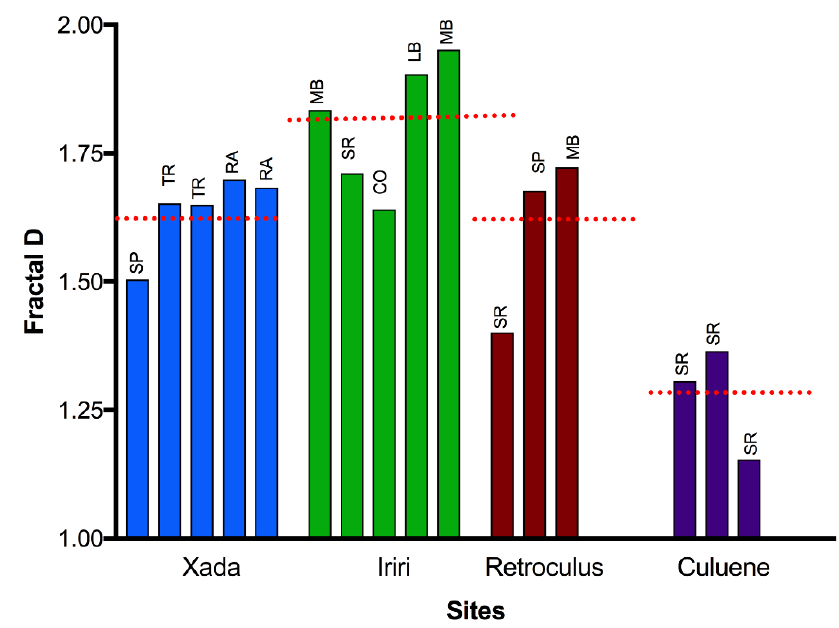
Figure 14. The Minkowski–Bouligand fractal dimension (D) as a measure of 3D habitat complexity. Each bar represents one of the first five habitat classes from Table 1. SP = Sand/pebbles, CO = Cobbles, TR = Textured rock, MB = Medium boulders, LB = Large boulders, SR = Solid rock. Dotted lines represent the mean for the site.